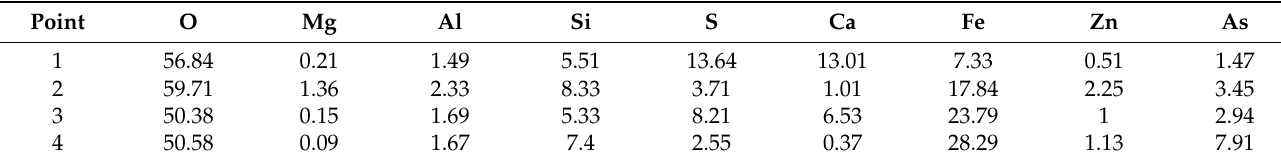
Table 6. The elemental compositions (at. %) for each EDS point.